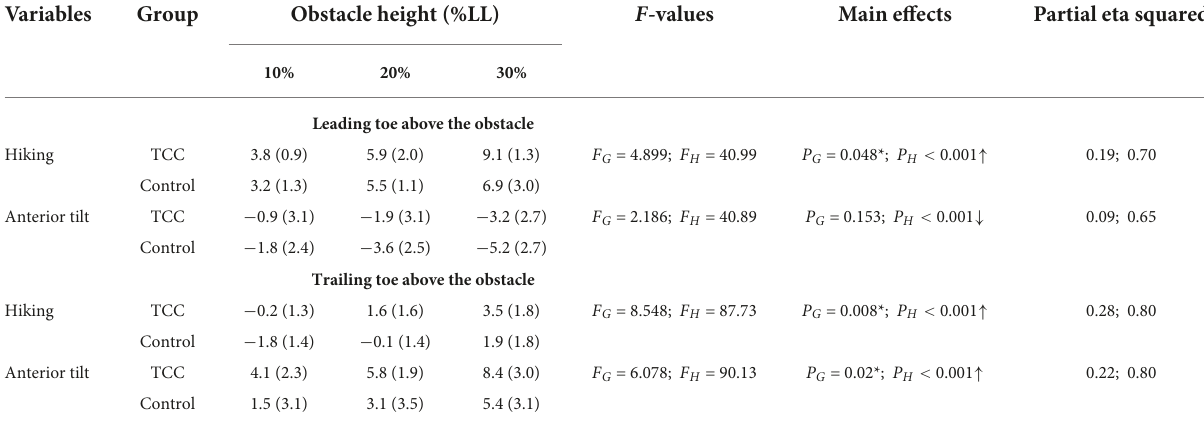
TABLE 3 Means (standard deviations) of the crossing angles of the pelvis relative to the global in TCC practitioners (TCC) and non-TCC controls (Control) when the leading or trailing toe was above the obstacles of heights of 10, 20, and 30% of the subjects’ leg length